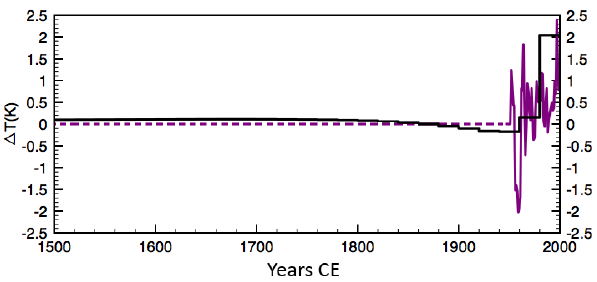
Figure 11. Meteorological record from Copiapó airport (in purple) used as input for calculating a synthetic temperature anomaly and result of its inversion using three singular values (in black). The solid purple line is the actual meteorological record (1950–2014); the dashed horizontal line is an extrapolation of the mean tempera- ture of the